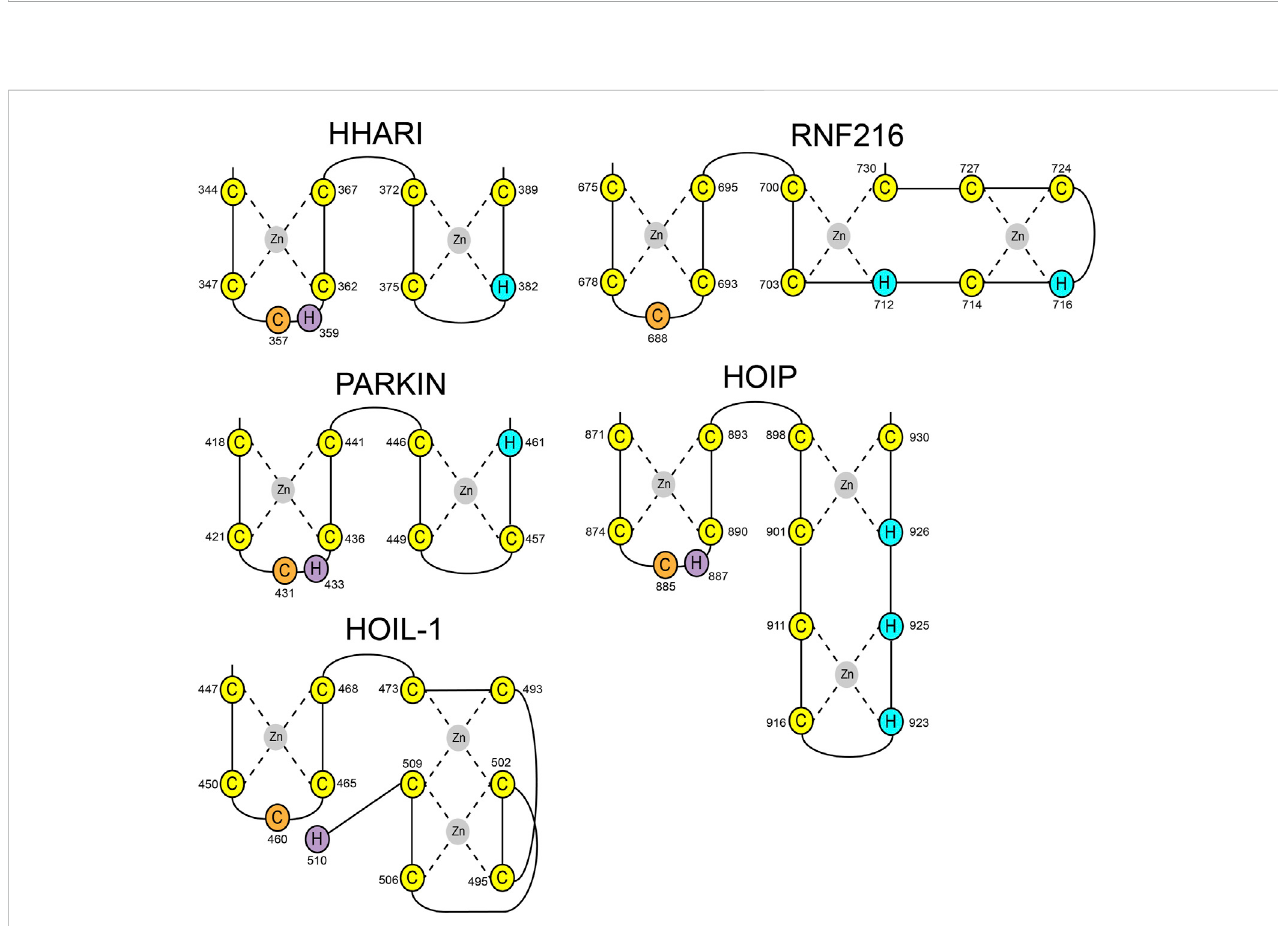
FIGURE 4 Schematic presentation of RING2 topologies of the RBR ligases HHARI, Parkin, HOIP, RNF216, and HOIL-1. Zinc coordinating cysteine and histidine residues are shown in yellow and blue, respectively. Catalytic cysteines are shown in orange. Catalytic histidine residues have been identi fi ed for HHARI, Parkin, HOIP, and HOIL-1